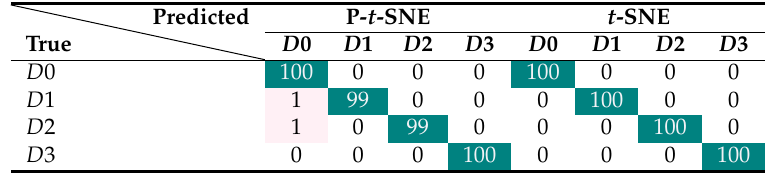
Table 5. Confusion matrix of the application of P- t -SNE and t -SNE damage detection and classification method presented in Sections 3 and 4: scenario 2 and the majority voting approach. Predicted P- t -SNE t -SNE D 0 D 1 D 2 D 3 D 0 D 1 D 2 D 3 True D 0 100 0 0 0 100